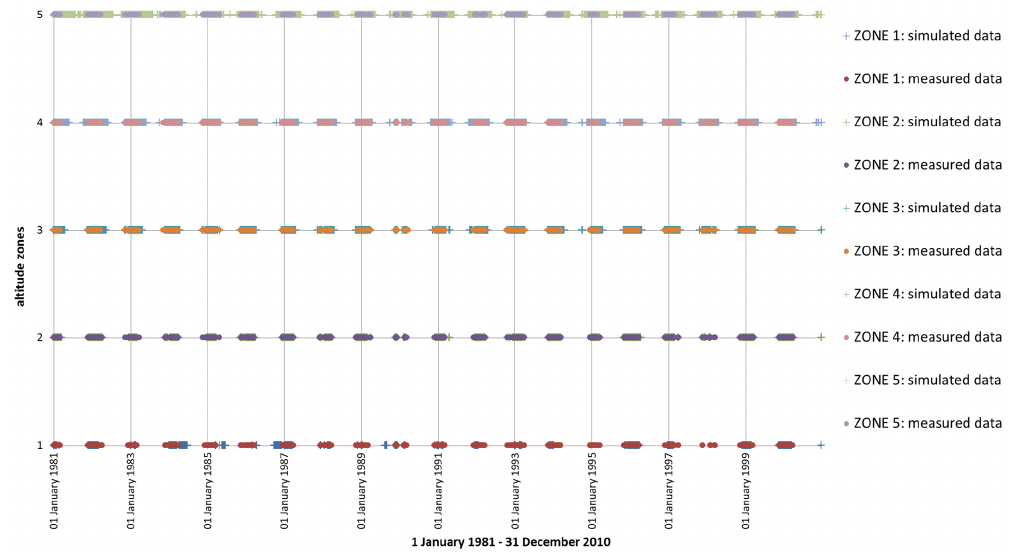
Figure 3. Comparison of simulated and measured snow cover duration in all zones of the Upper Hron during the period of 1981–2000. Circles show measured presence of snow cover, plusses show simulated presence of snow